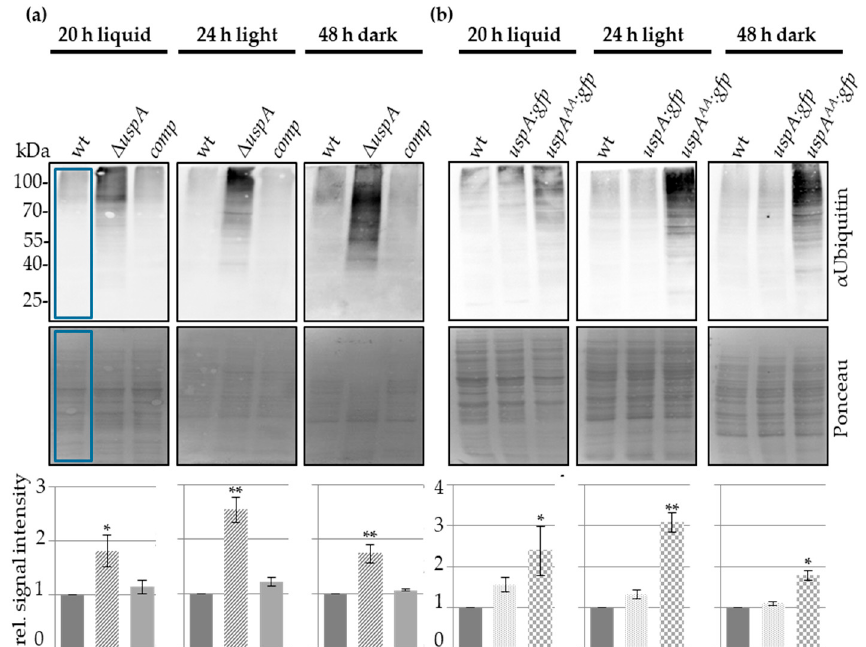
Figure 4. UspA balances the amount of total ubiquitinated proteins during fungal development. Western blot experiments were performed with protein crude extracts of wild type (wt), ∆ uspA , ∆ uspA complementation (comp) ( a ), as well as of A. nidulans strains expressing the functional uspA:gfp fusion or the inactive uspA AA :gfp fusion ( b ). All strains were grown for 20 h in minimal liquid medium at 37 ◦ C to enable vegetative growth. The mycelium derived from this vegetative development was transferred onto solid agar plates that contained equal amounts of minimal medium and incubated either for 24 h in light at 37 ◦ C to induce asexual development or for 48 h in darkness at 37 ◦ C to induce sexual development. As a loading control, the proteins on the nitrocellulose membrane were stained with Ponceau. The whole lane, marked with a blue frame exemplarily for wild type, was used for the quantification of the signal intensity and normalized to the Ponceau signal with the Bio-1D software. The quantification is based on up to four biological replicates. The standard error of the mean is shown, and significances of di ff erences between wt and ∆ uspA or between wt and uspA AA :gfp were calculated with t -test (** p ≤ 0.01; * p ≤